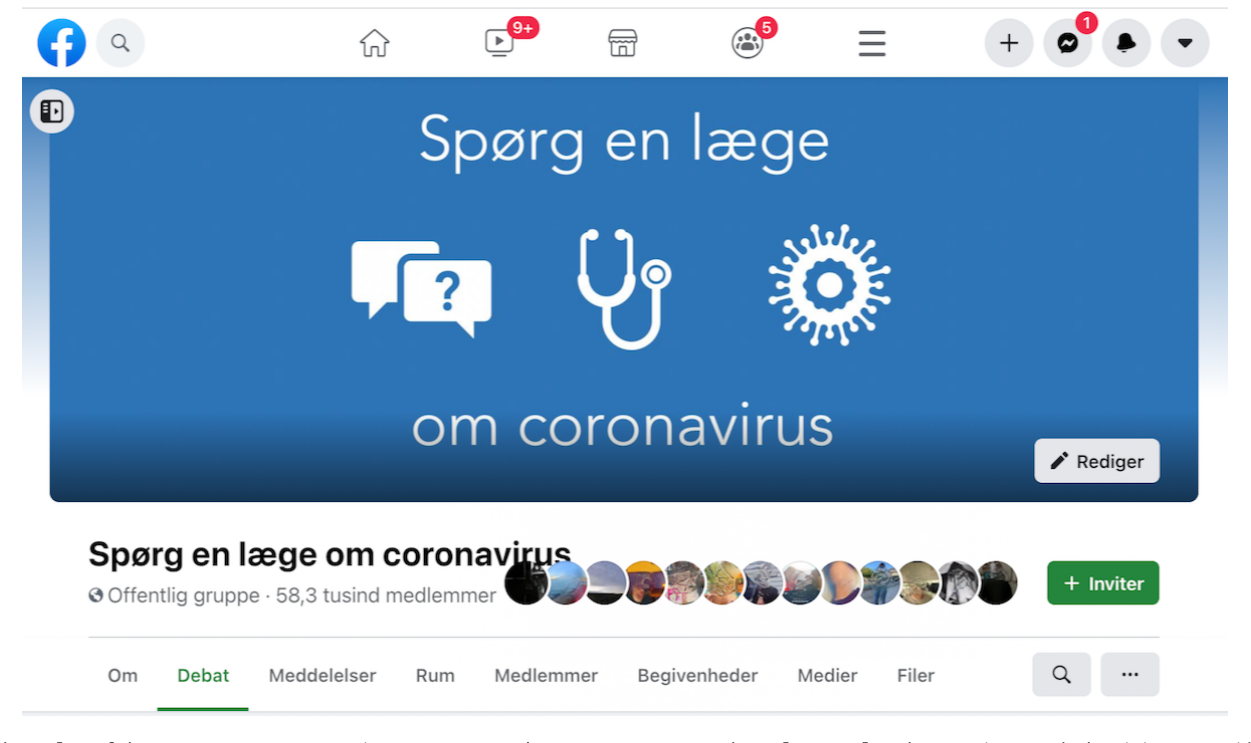
Figure 1. A screenshot from the Facebook group, “Spørg en læge om coronavirus,” which literally translates to “Ask a doctor about